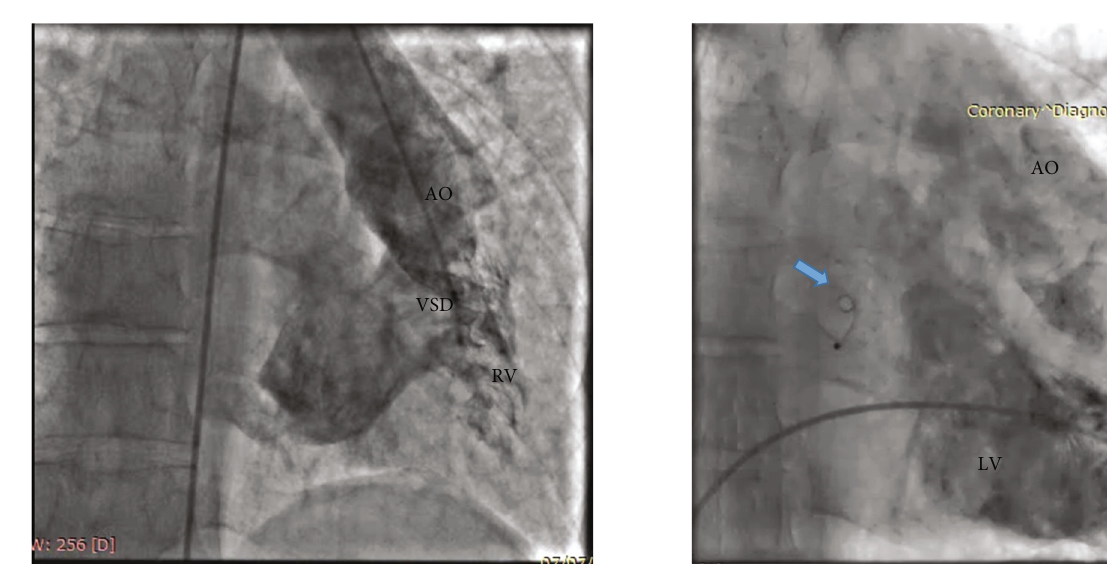
Figure 3: AFR is seen in the proper